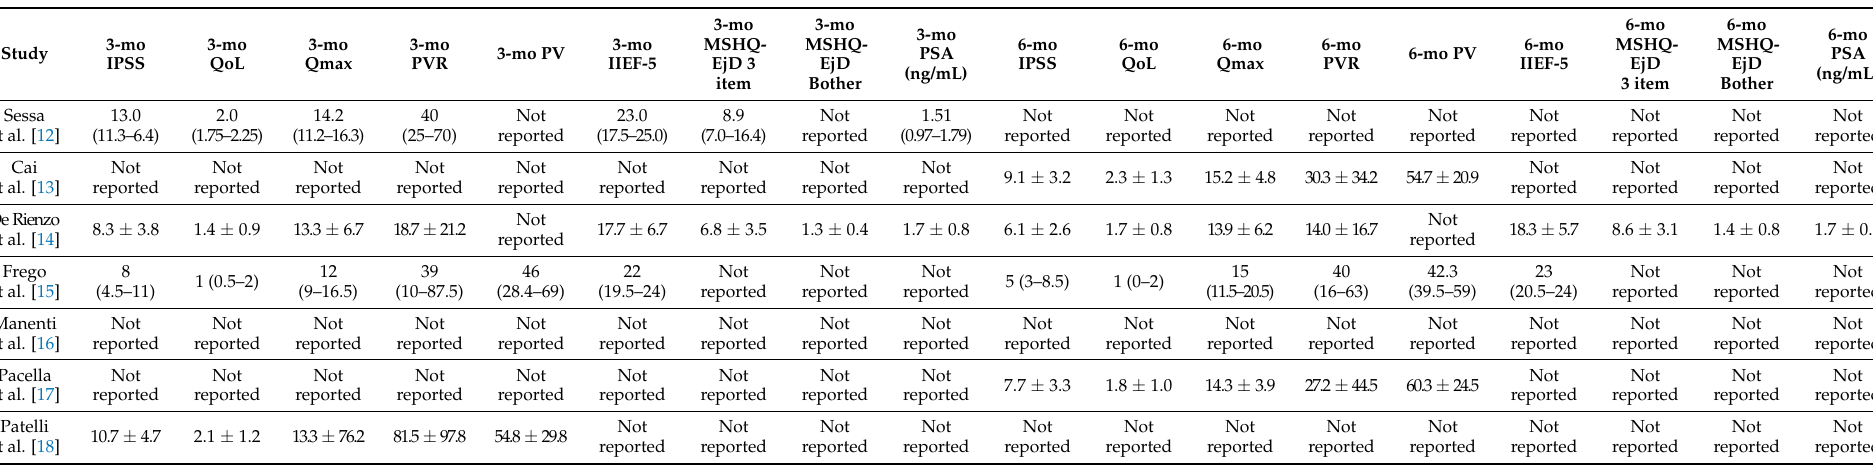
Table 4. Short and mid-term postoperative surgical and functional outcomes of studies on Trans Perineal Laser Ablation (TPLA) of prostate included in this